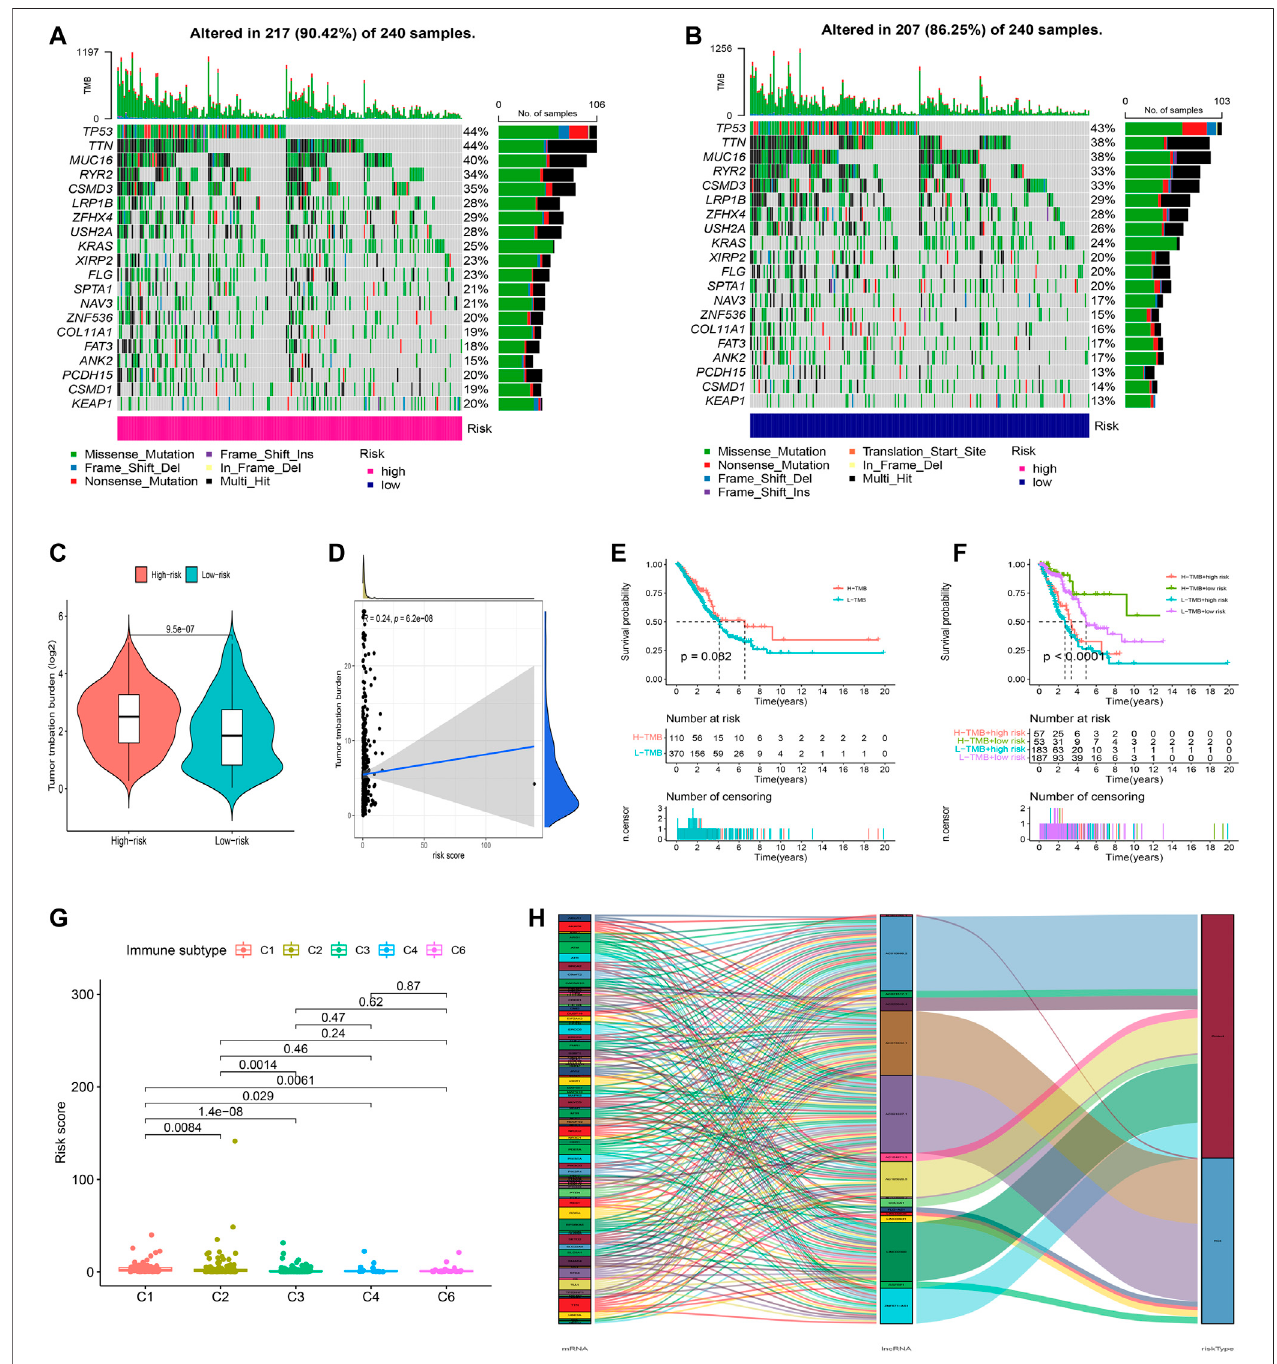
FIGURE9| ExplorationoftumormutationburdenandvisualizationoflncRNAnetworks. (A,B) Waterfallplotofsomaticmutationfeaturesestablishedwithhigh-and low-riskgroups. (C) Tumormutationburdeninthehigh-riskand low-risk groups. (D) Correlationbetweenriskscoreand TMB. (E) Kaplan – Meiercurve oftheOSamong thehigh-andlow-TMBgroups. (F) Survivalanalysisamongfourpatientgroupsstrati fi edbybothTMBandriskscore. (G) Correlationbetweentheriskscoreandimmune subtype. (H) Connection degree between the oxidative stress-related lncRNAs, oxidative stress-related genes, and risk types.